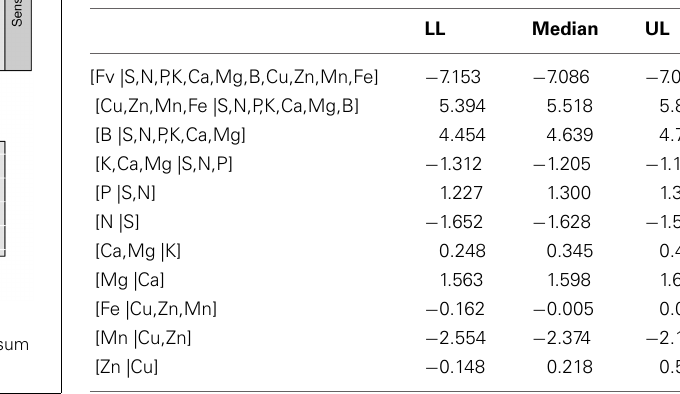
Table 3 | Confidence intervals of ilr values ( ± t 0 . 025 negative (TN) specimens ( n = 20) in the Brazilian mango data set (LL, lower limit; UL, upper limit).